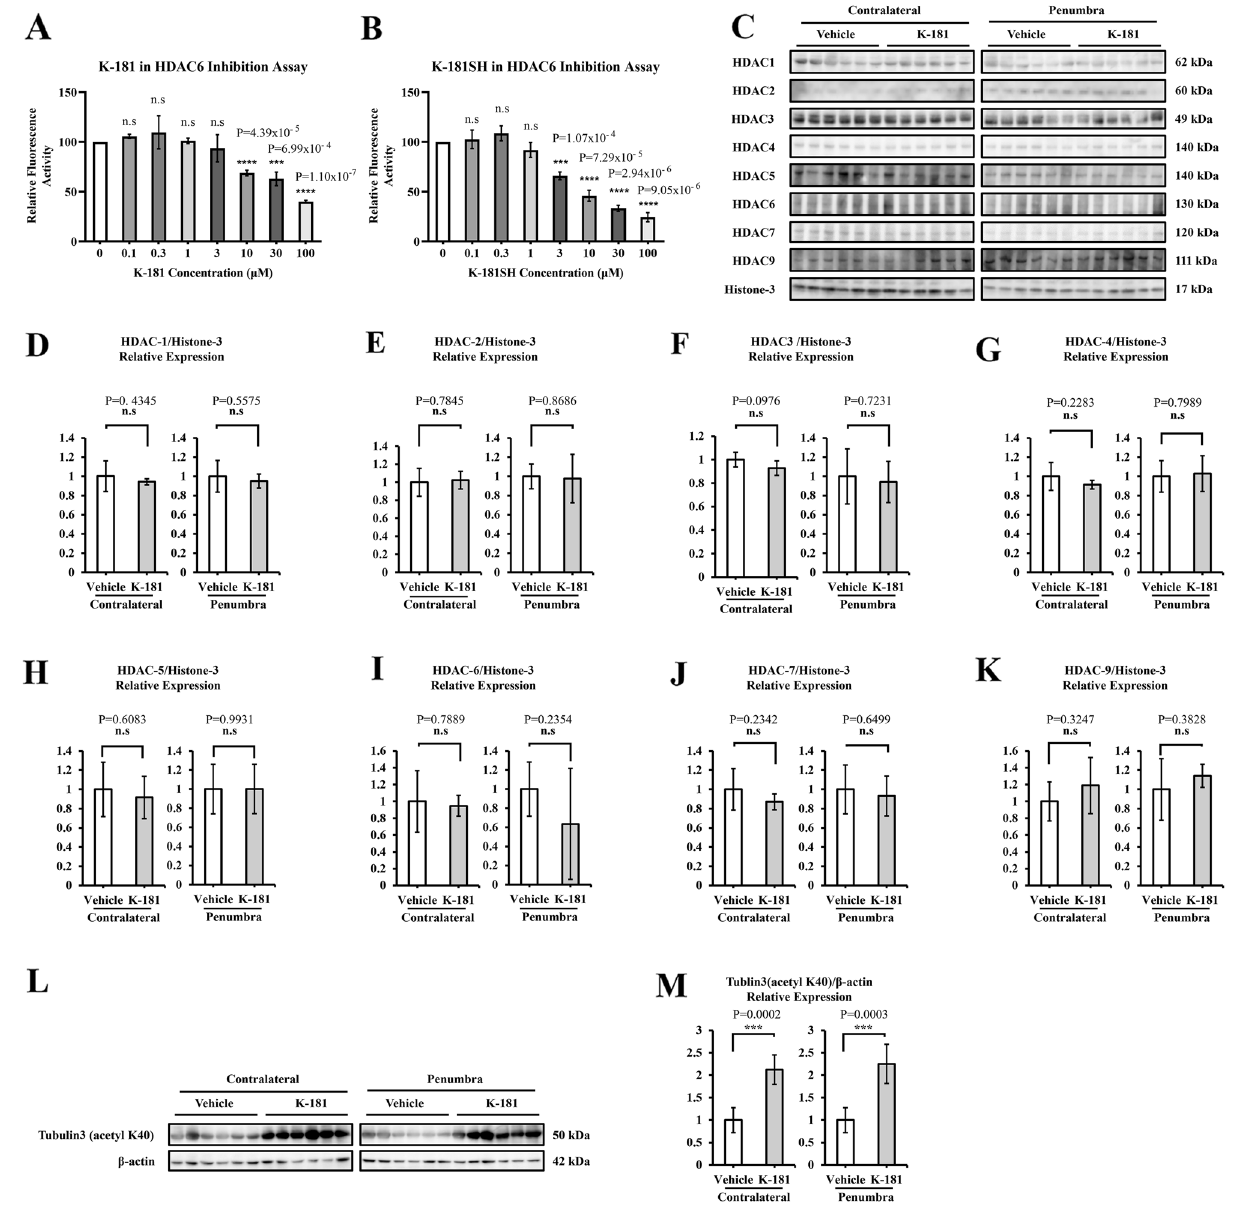
Figure 6. K-181 selectively inhibits HDAC6 activity and enhances Tubulin acetylation. ( A , B ) HDAC6 inhibition assay of 0.1, 0.3, 1, 3, 10, 30, 100 μM K-181 ( A ) and K-181SH ( B ). N = 3. ( C – K ) Western Blot images ( C ) and quantification of HDAC1 ( D ), HDAC2 ( E ), HDAC3 ( F ), HDAC4 ( G ), HDAC5 ( H ), HDAC6 ( I ), HDAC7 ( J ) and HDAC9 ( K ) expression in vehicle and K-181 treated mice brains. N = 6. ( L , M ) Western Blot images ( L ) and quantification ( M ) of Tubulin3 (acetyl K40) in vehicle and K-181 treated mice brains. N =